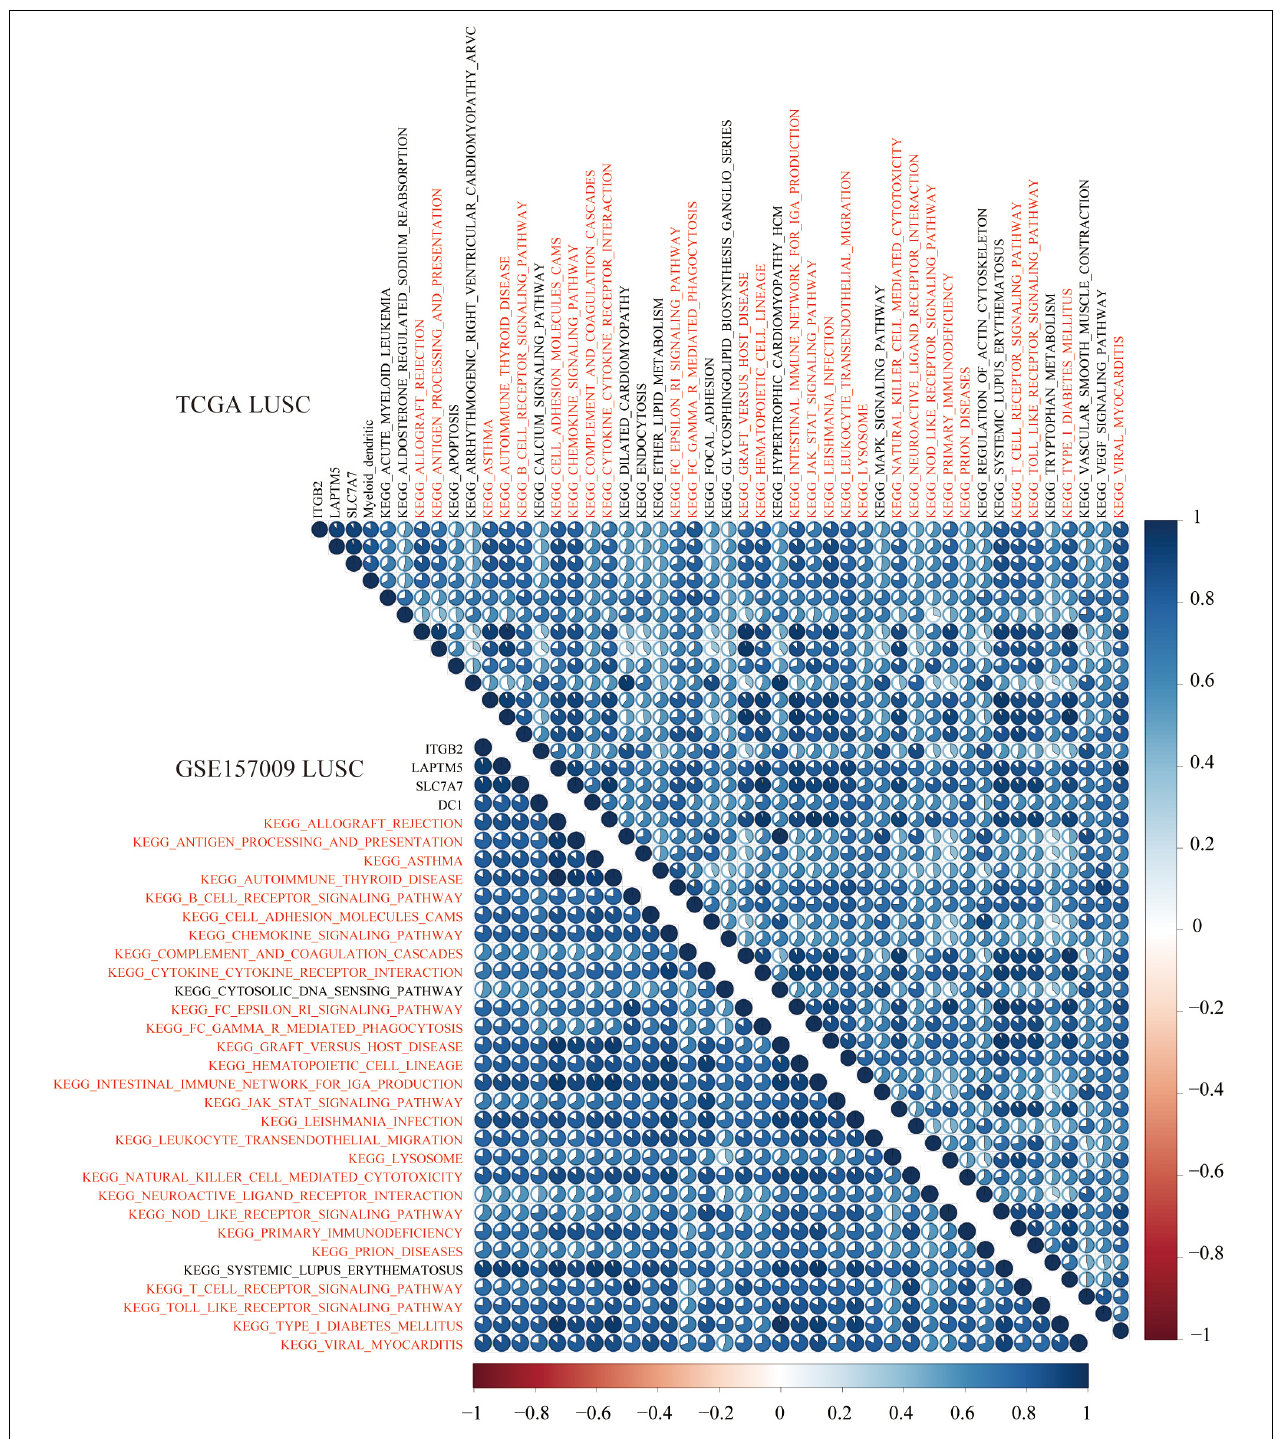
FIGURE 13 | In LUSC tissues of TCGA and GSE157009, the above 27 shared KEGG pathways were highly related to DC1 and ITGB2, LAPTM5, and SLC7A7 and are marked in red.